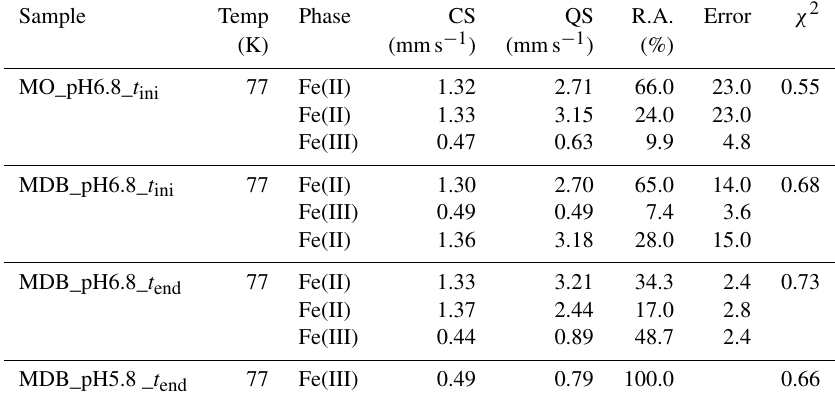
Table 2. Fitting results of Mössbauer spectroscopy. CS stands for centre shift, QS stands for quadrupole splitting, R.A. stands for relative abundance determined by integration under the curve, and χ 2 represents the goodness of fit. Sample collection took place at t ini (the initial time point) and t end (the end time point). MO denotes mineral only, and MDB denotes mineral and dead